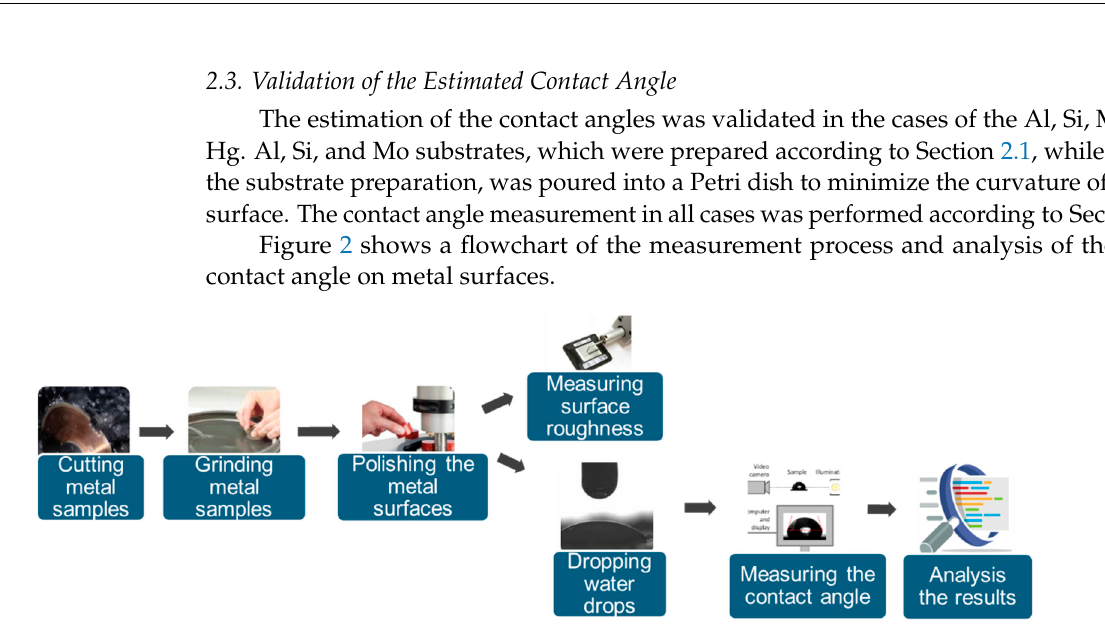
Figure 2. Flow chart of the measurement.